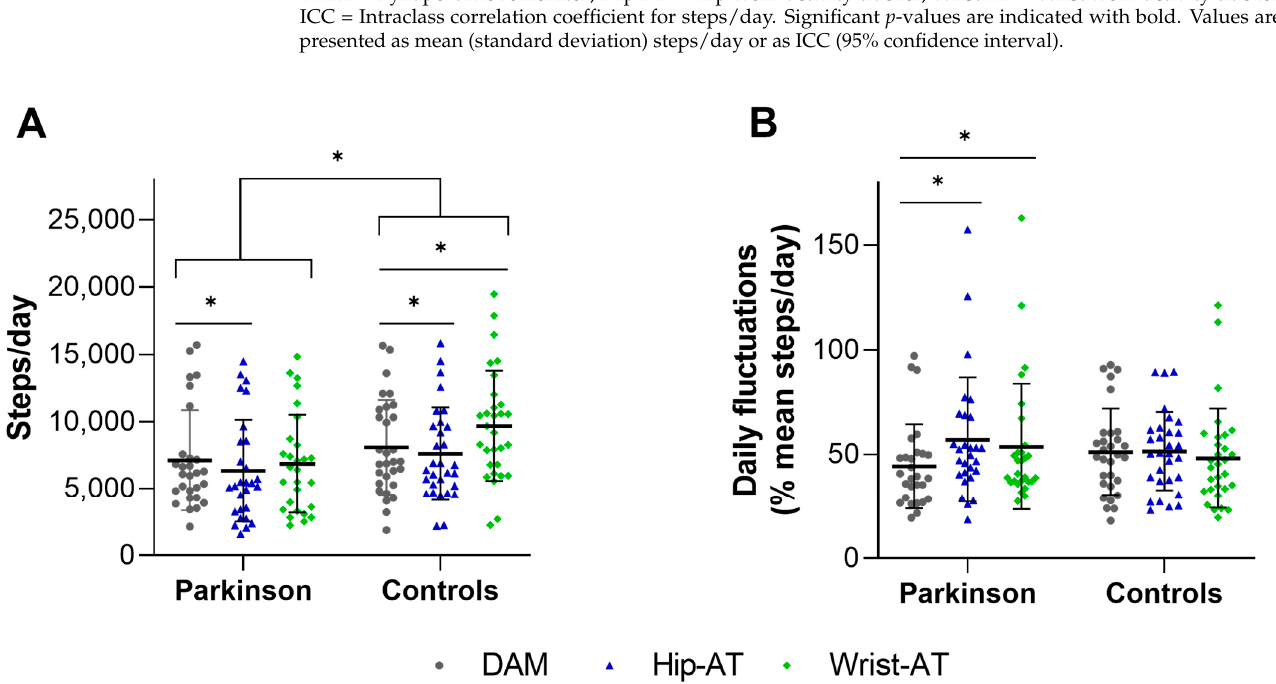
Table 2. Criterion validity.